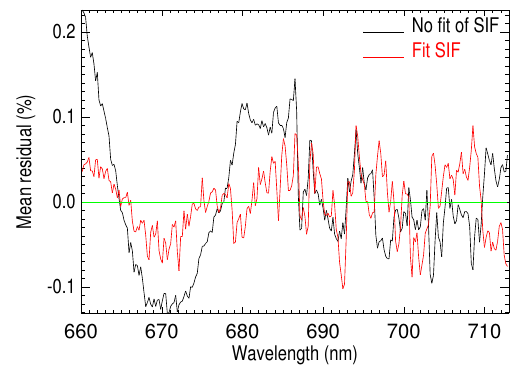
Figure 17. Similar to Fig. 7 but showing the mean of the resid- uals within the full band algorithm fitting window for ocean pixels with moderate to high amounts of ocean fluorescence (FLH > 0.4mWm − 2 nm − 1 sr − 1 ) for a single day (1 July